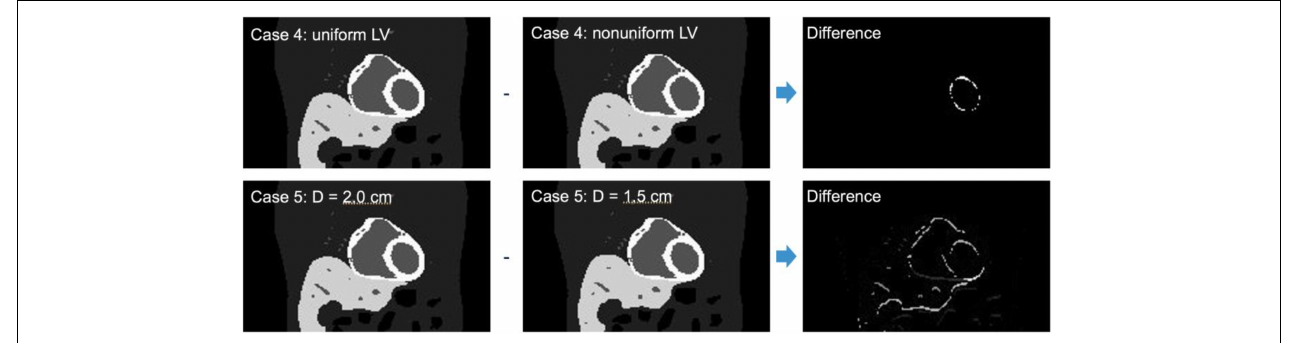
FIGURE 6 | Similar activity map as in Figure 5 for non-uniform LV thickness (Case 4) and uniform LV thickness but with diaphragm displacement of D = 1.5 cm (Case 5) and their corresponding differences.